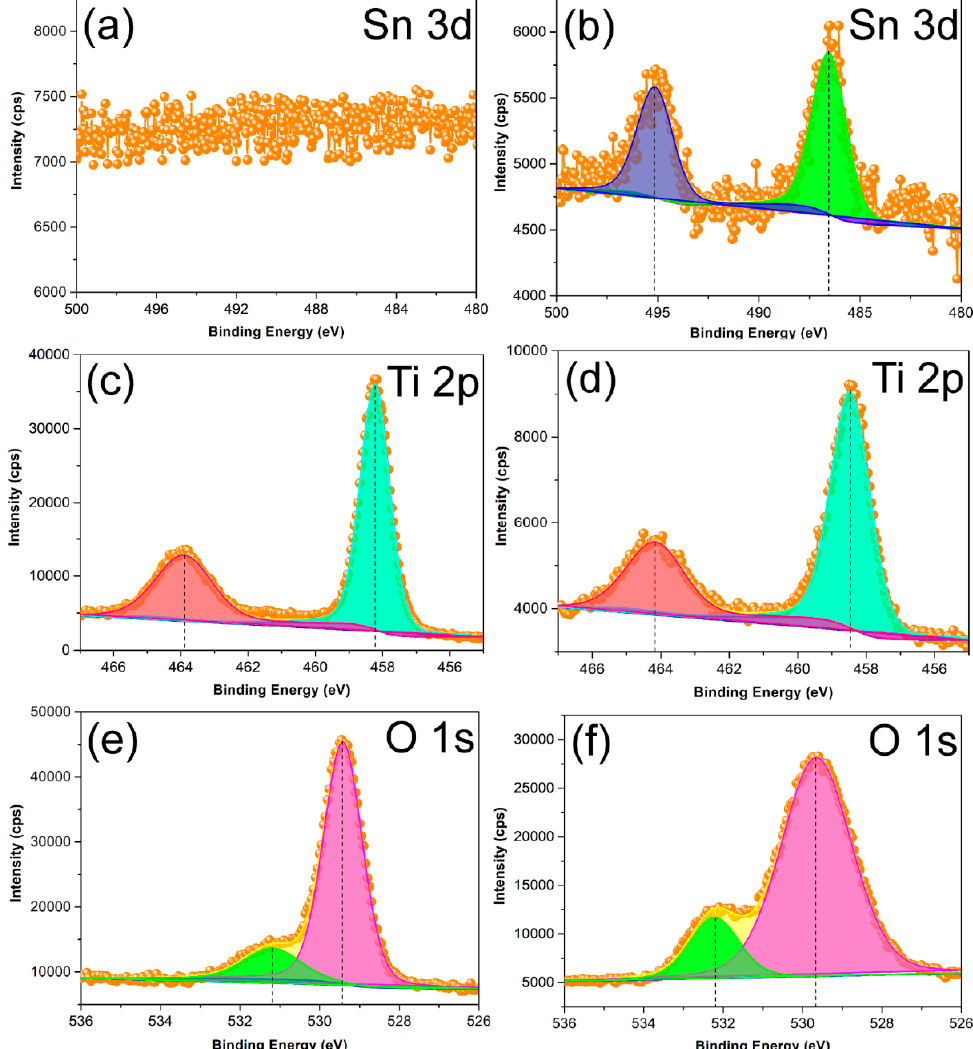
Figure 9. X-ray photoelectron spectroscopy (XPS) results of the TiO 2 hierarchical nanospheres (24 h) ( a , c , e ) and STO hierarchical nanospheres with a 5% molar ratio of n Sn / n Ti ( b , d , f ).